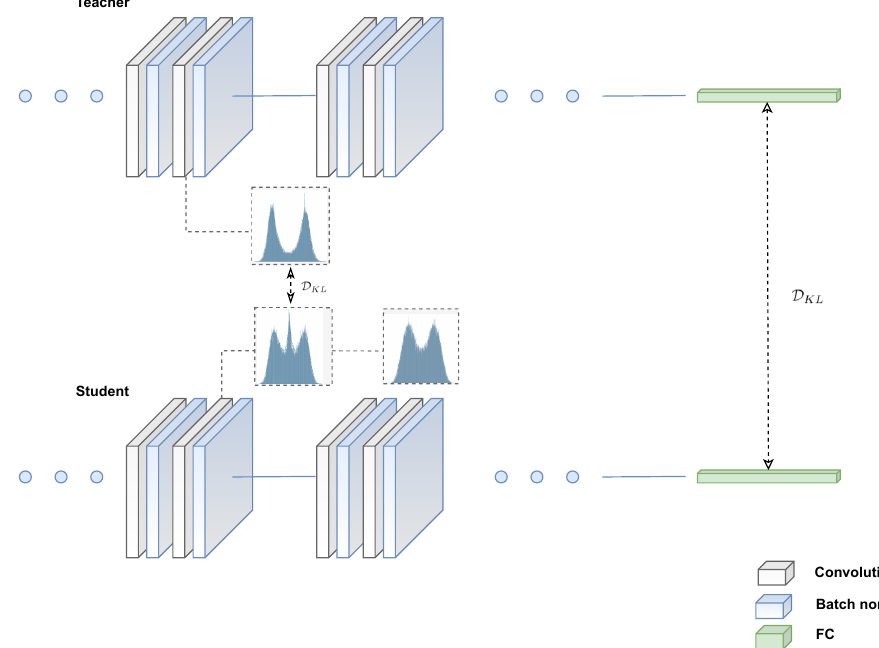
Figure 7. WDM scheme, where we minimize the L WDM in order to obtain a better bimodal distribu- tion, as well as KD of the logits between the teacher and the